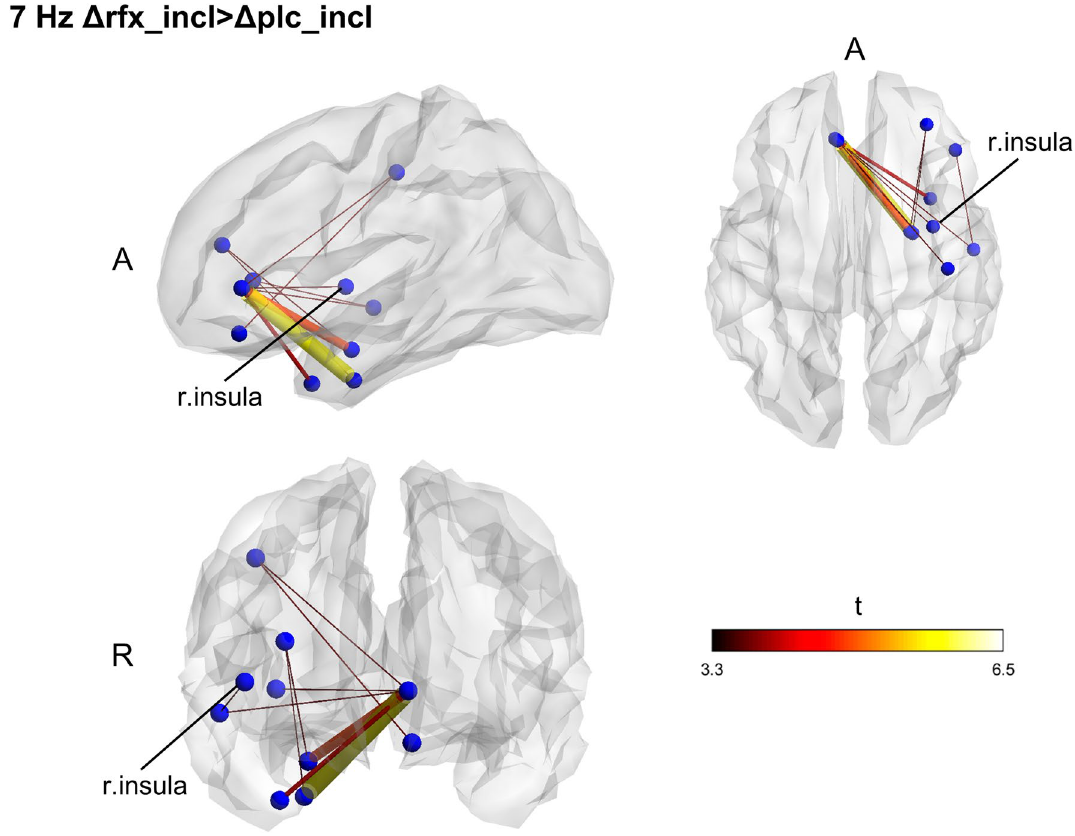
Figure 3. Between groups functional connectivity comparison during CBG in post-treatment session. Theta (7 Hz) higher fc connectivity network found in Rifaximin group during the inclusion condition. The cluster of higher connectivity involves the frontal and temporal lobe, mainly in the right hemisphere. The right insular cortex is highlighted. Size and color of the edges are proportional to the t-statistic (t) value (Δ = post–pre matrices, A anterior, R